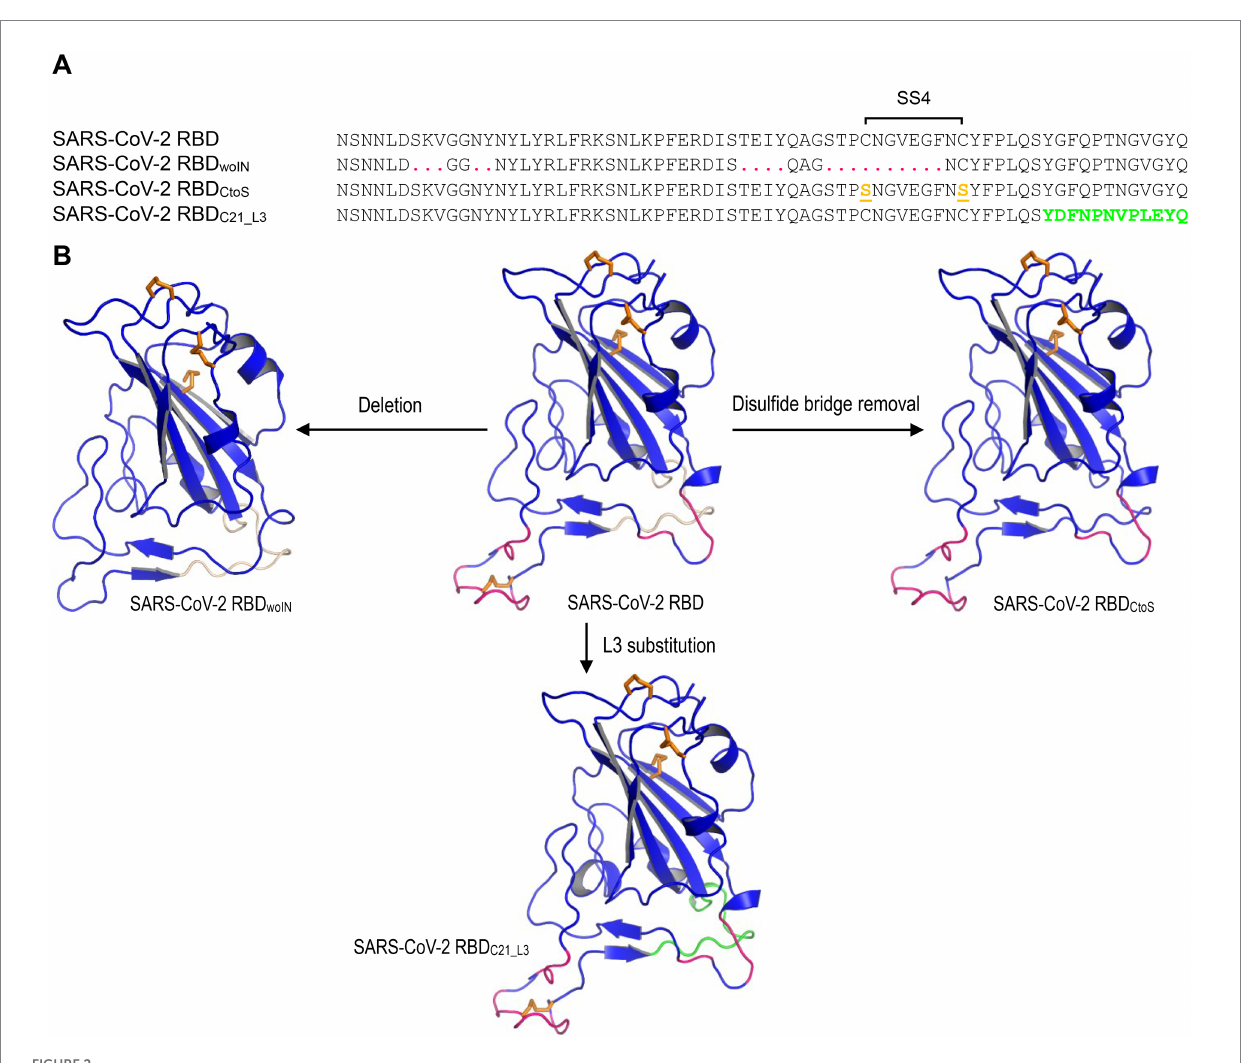
FIGURE 2 The SARS-CoV-2 RBB mutants for MD simulations. (A) The designed RBD mutant sequences. SARS-CoV-2 RBD woIN represents a deletion mutant with corresponding amino acids in RBML1 and RBML2 (marked in red) deleted and “woIN” denotes “without insertions.” SARS-CoV-2 RBD CtoS represents a mutant of two Cys to Ser mutations that remove the SS4 (underlined once and shown in orange). SARS-CoV-2 RBD C21_L3 represents a mutant whose RBML3 is substituted by the equivalent of the CoVZXC21 RBD (marked in green). (B) Structures of the SARS-CoV-2 RBD mutants generated by homology modelling with SARS-CoV-2 RBD (PDB entry 6LZG) as